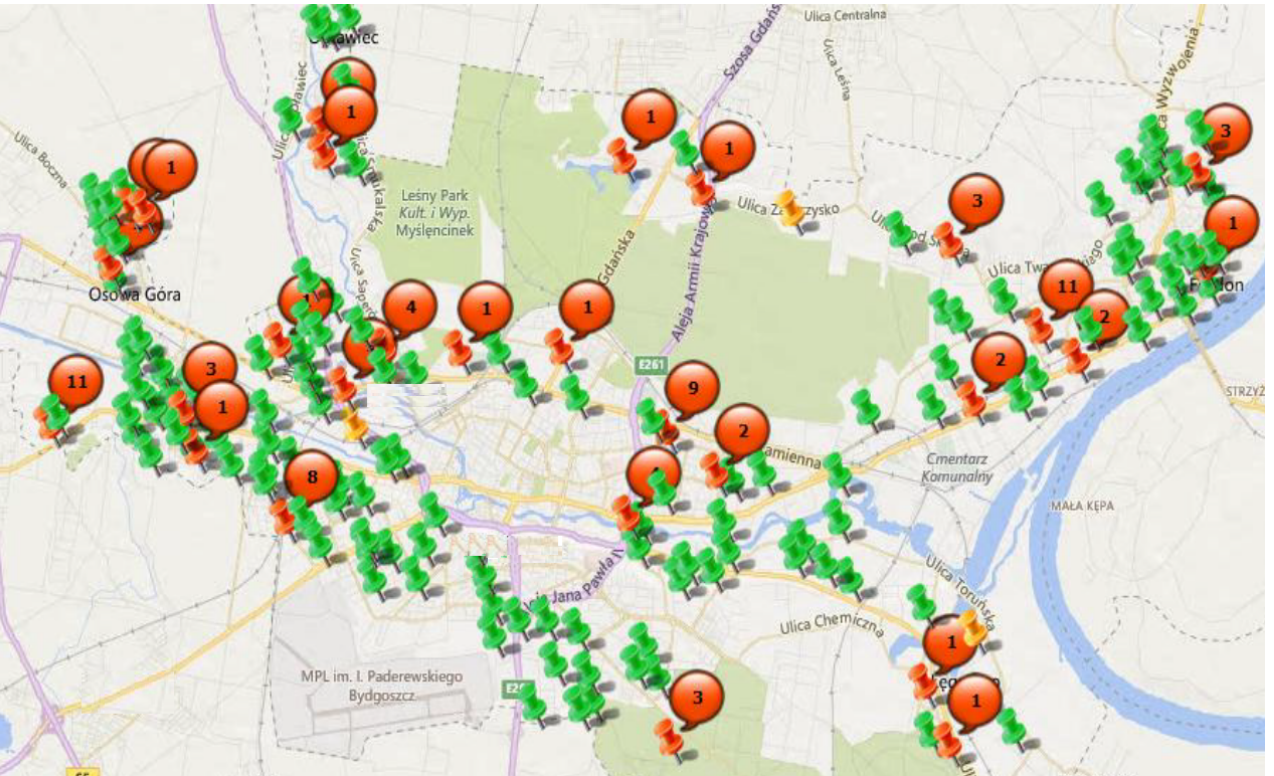
Figure 6. Arrangement of the tested circuits of lighting fittings.